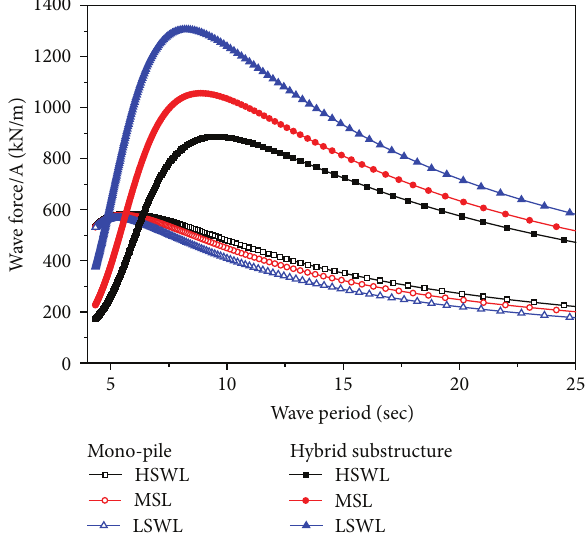
Figure 4: Comparison of wave forces for various water depths.